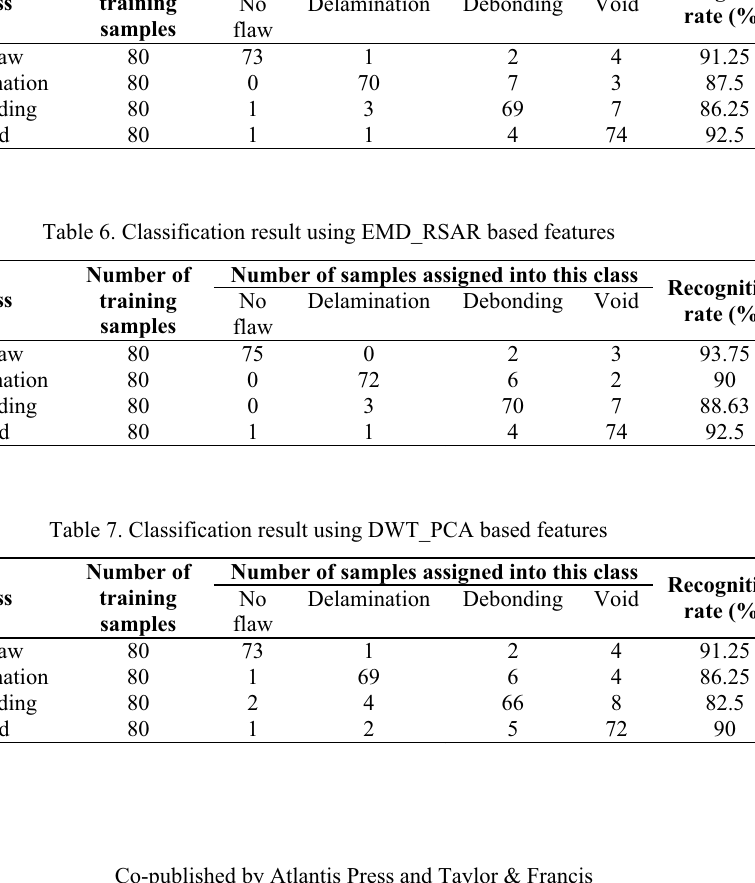
Table 5. Classification result using EMD_PCA based features Number of samples assigned into this class